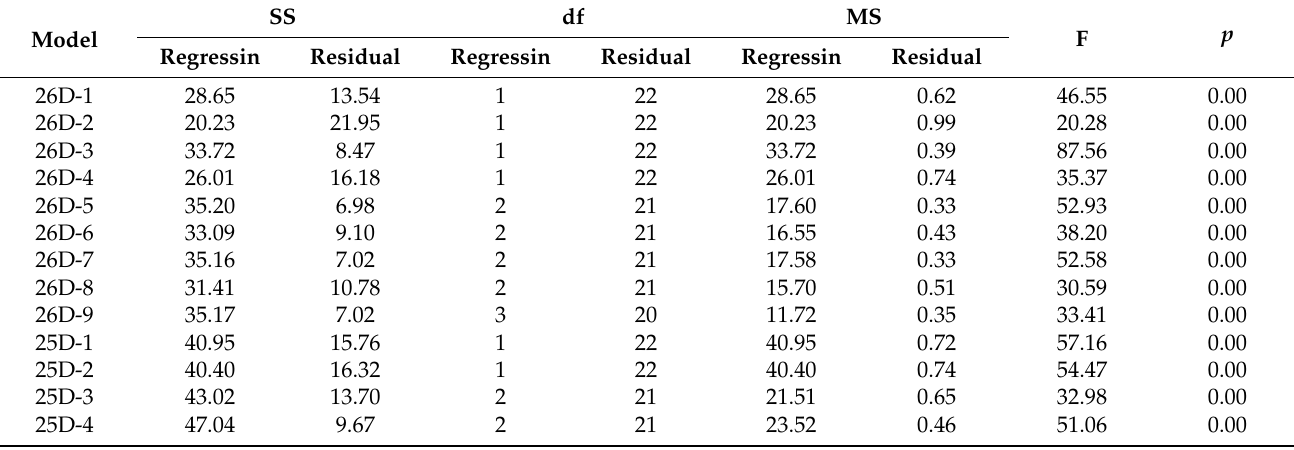
Table 5. ANOVA test for all models: sum of squares (SS), degree of freedom (df), mean square (MS), F-statistic (F) and p -value ( p ) for setpoint temperature of 26 and 25 ◦ C for mean daily data